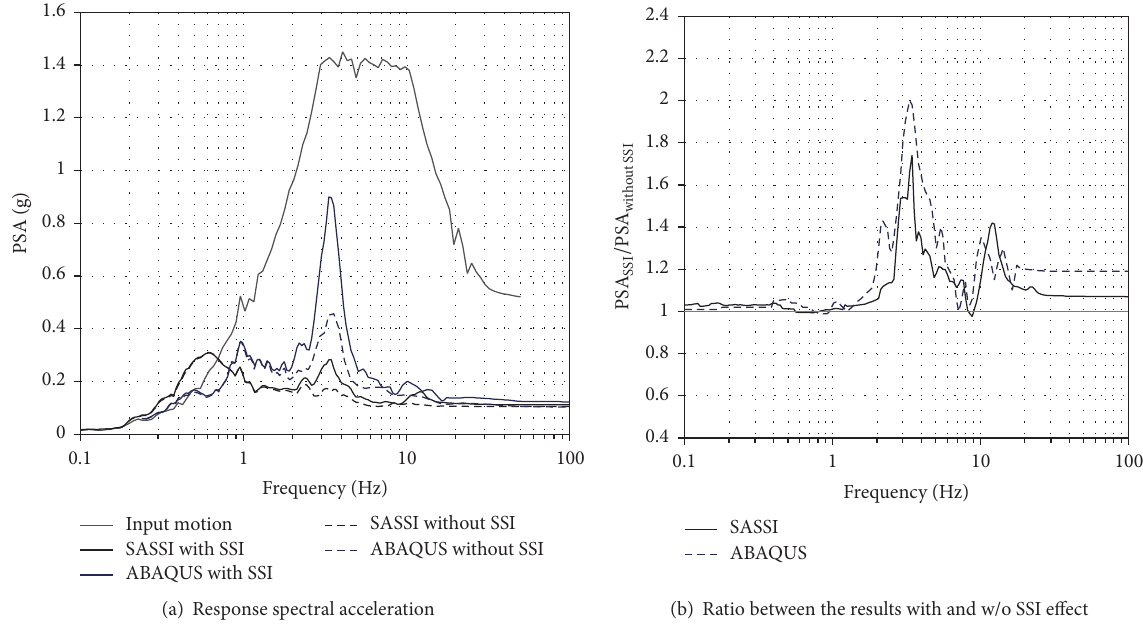
Figure 9: Comparison of results between frequency domain (SASSI) and time domain (ABAQUS) for the top of the Reactor Containment Building.